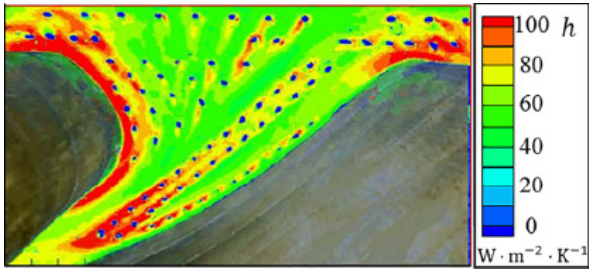
Figure 9. Local heat transfer coefficient in presence of film holes [95]. Reprinted with permission: